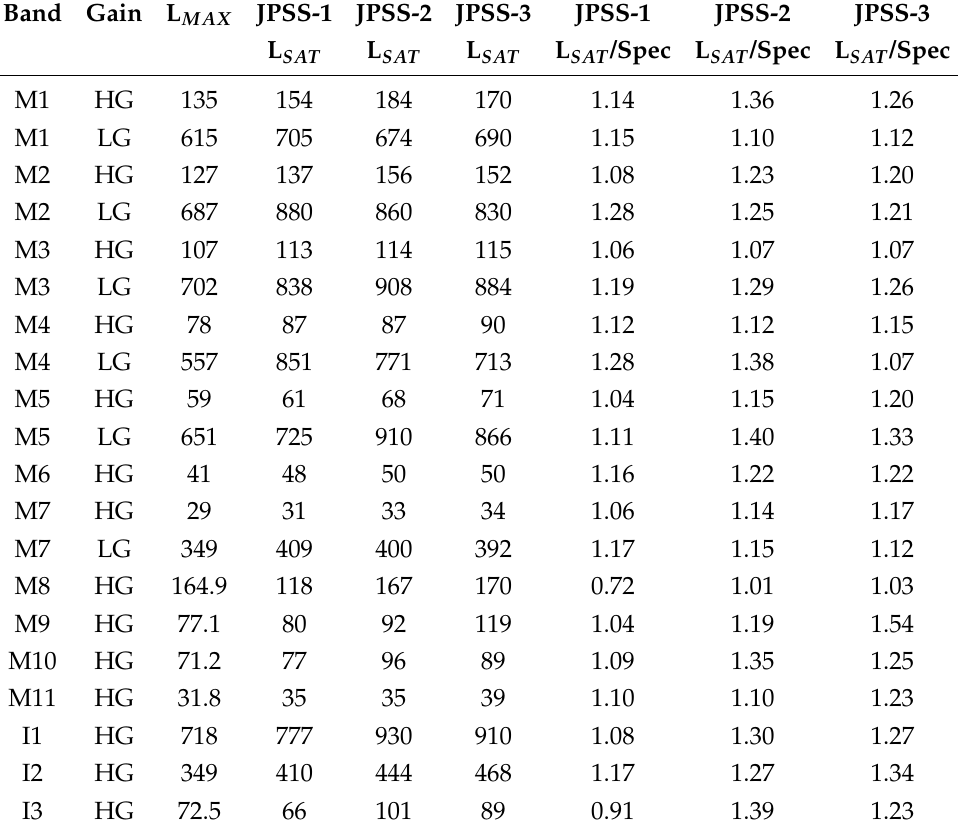
Table 3. JPSS-3 VIIRS RSB L SAT relative to the sensor specification [10]. JPSS-1 and JPSS-2 results are included for